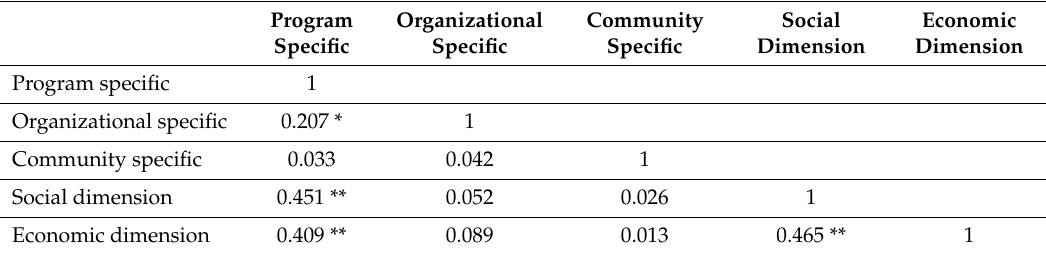
Table 8. Correlation matrix.